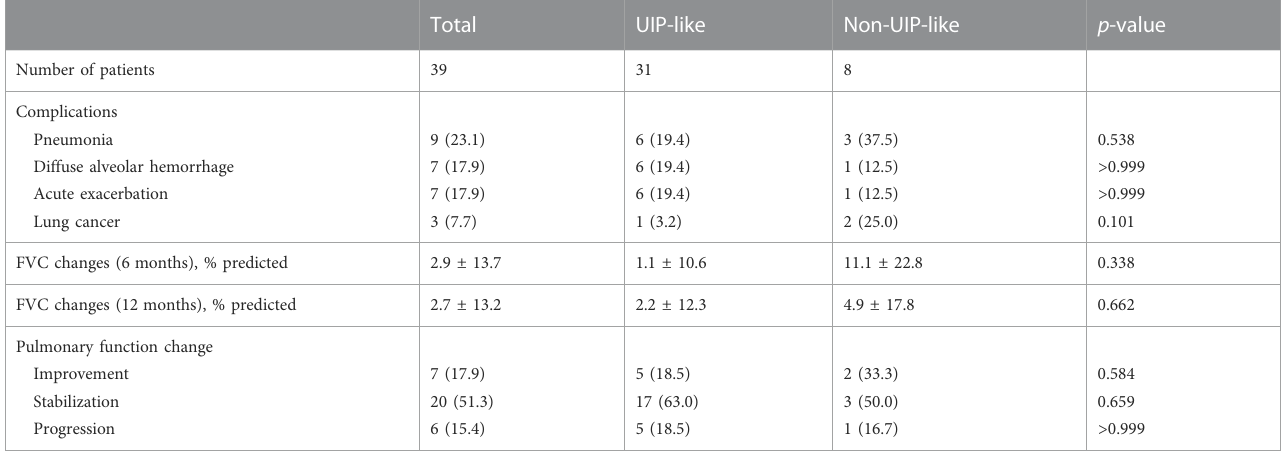
TABLE 4 Comparison of the clinical course according to the HRCT patterns in patients with